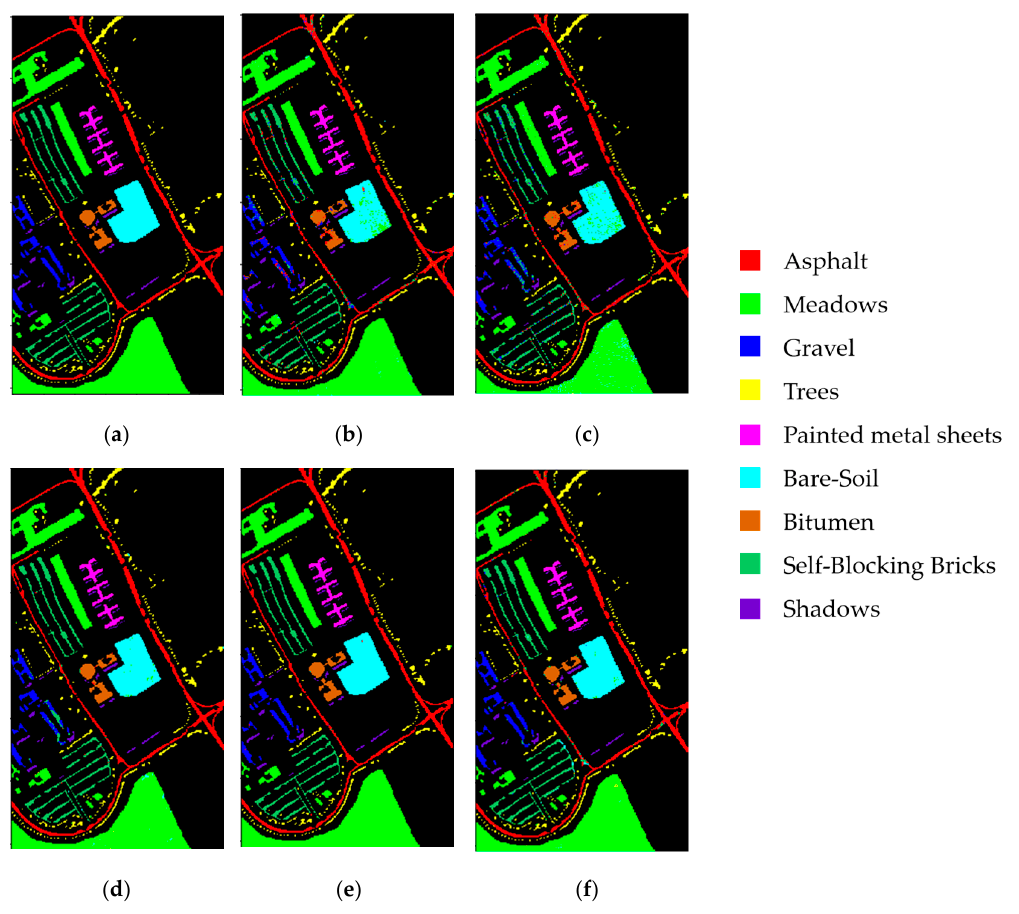
Figure 10. The classification map for the Pavia University dataset of different networks . ( a ) ground truth; ( b ) SAE (OA: 94.18%); ( c ) 1D-CNN (OA: 92.06%); ( d ) 3D-CNN (OA: 98.20%); ( e ) DC-CNN (OA: 99.66%); ( f ) S2FEF-CNN (OA: 98.04%).